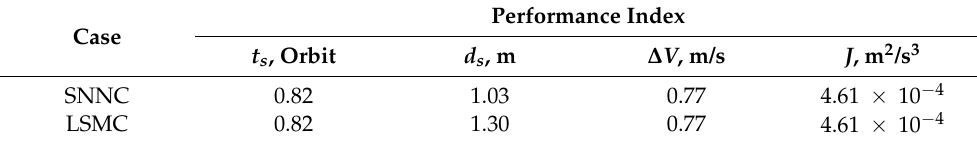
Table 3. Performance indices.